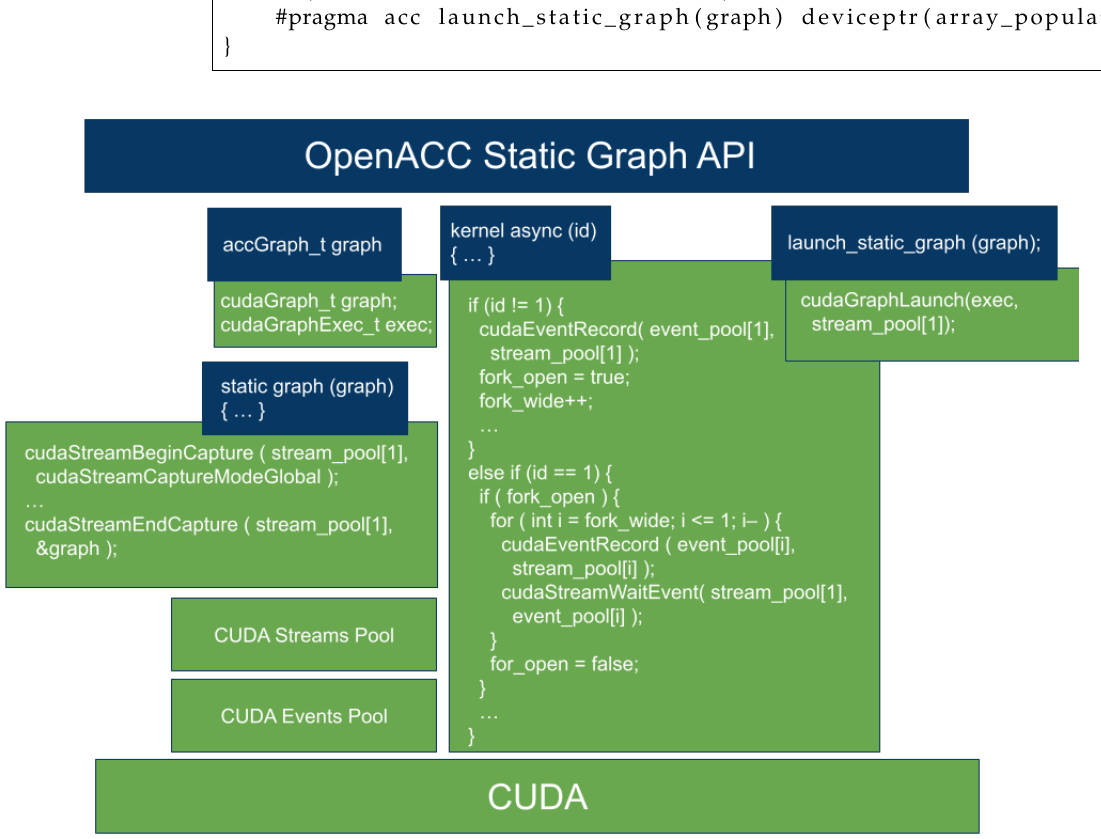
Figure 6. OpenACC static graph API mapping on the CUDA programming